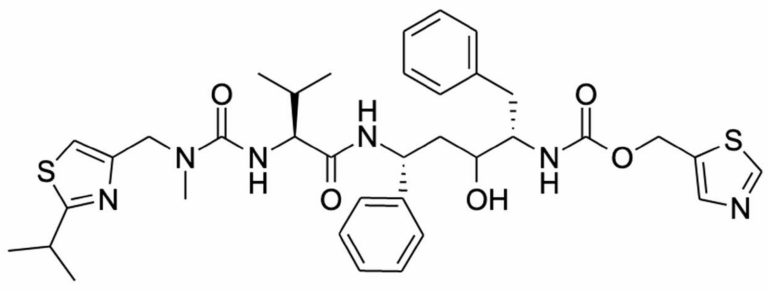
Figure 1. Chemical structure of